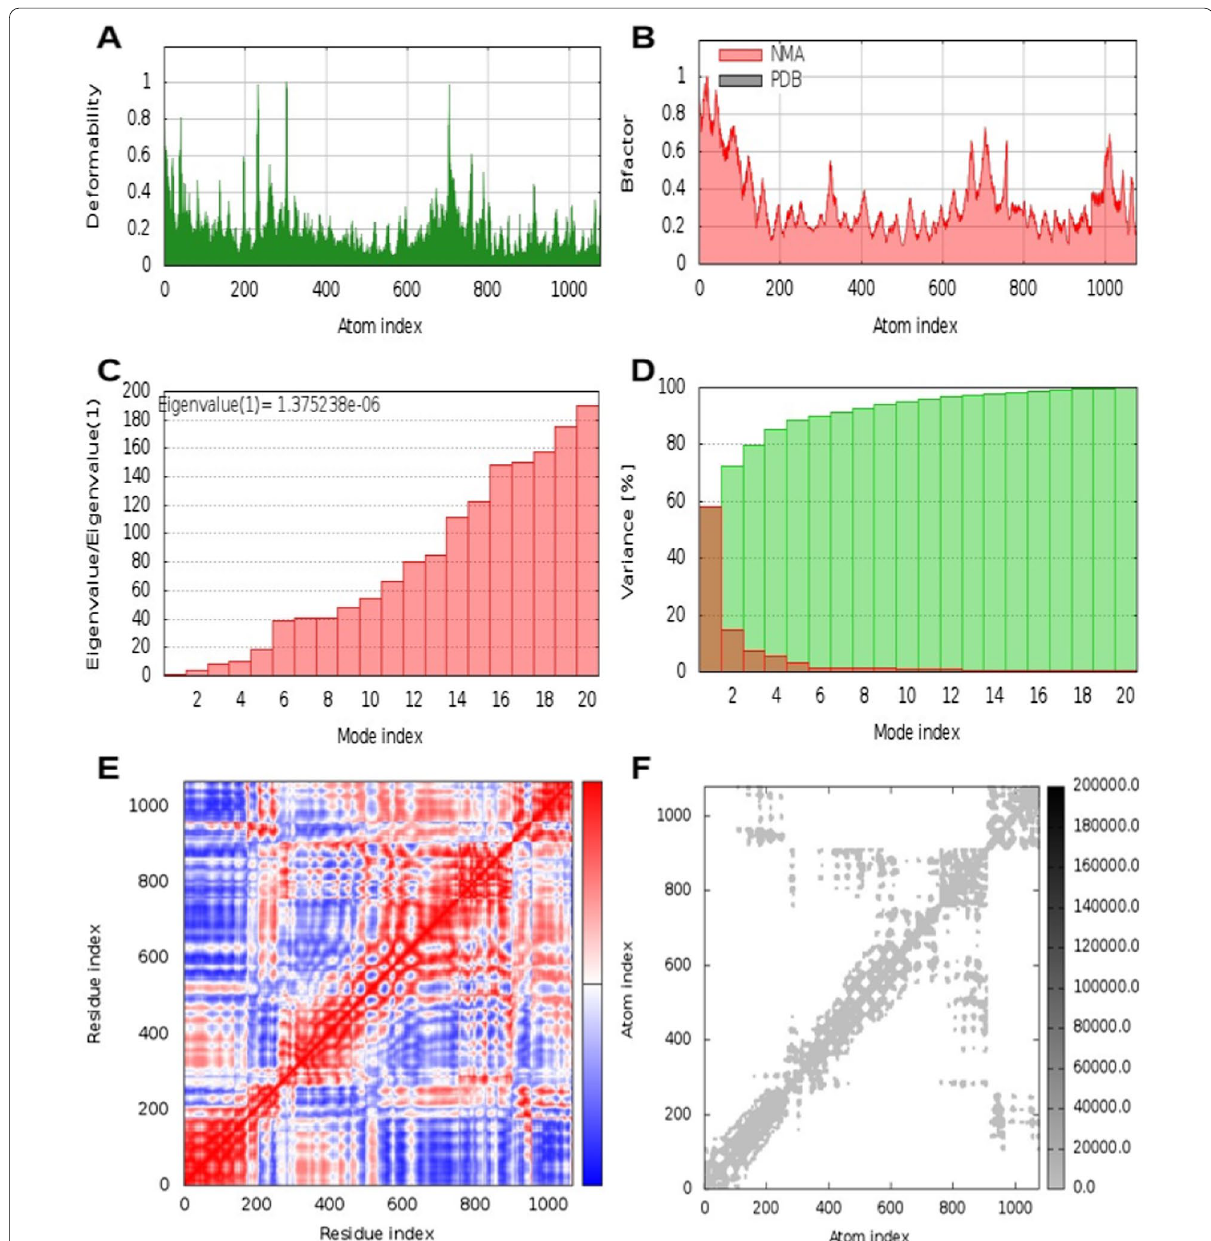
Fig. 5 Normal mode analysis output for the hs CENP-HIKM complex model, showing the ( A ) main-chain deformability, ( B ) B-factor (Å 2 ), ( C ) eigenvalues, ( D ) variance, ( E ) covariance map and the ( F ) elastic network